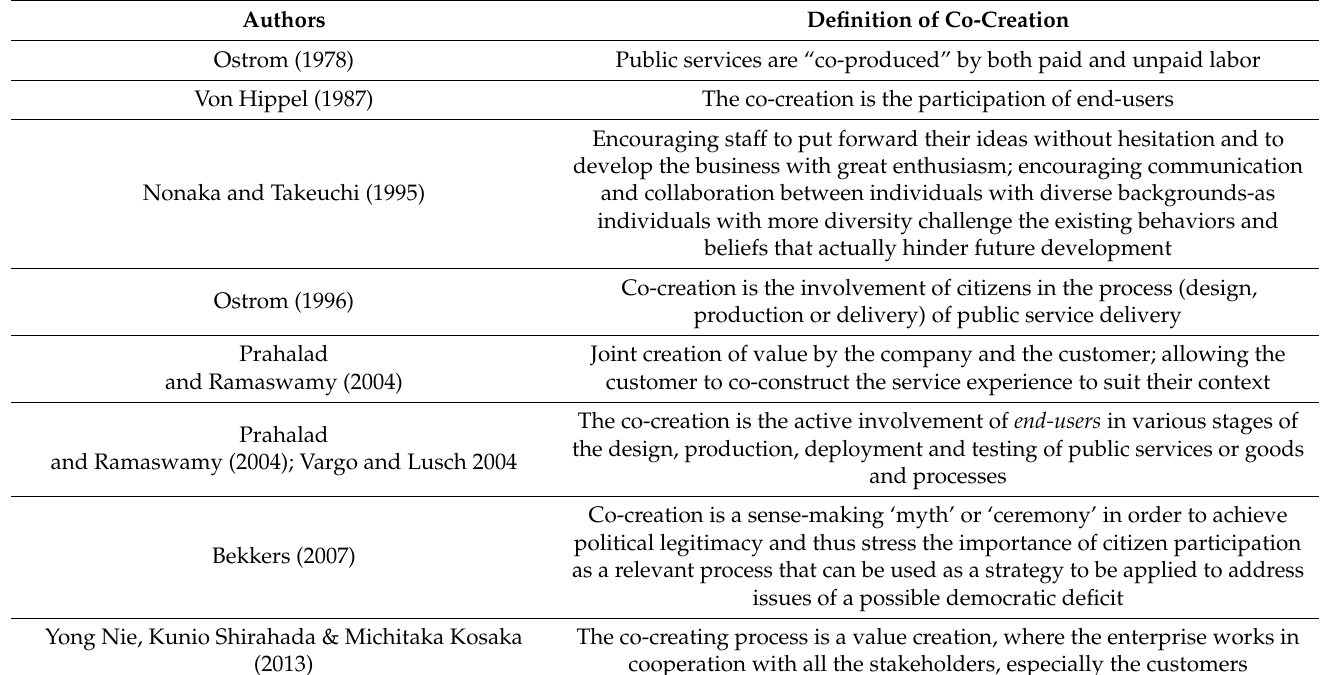
Table 1. Co-creation